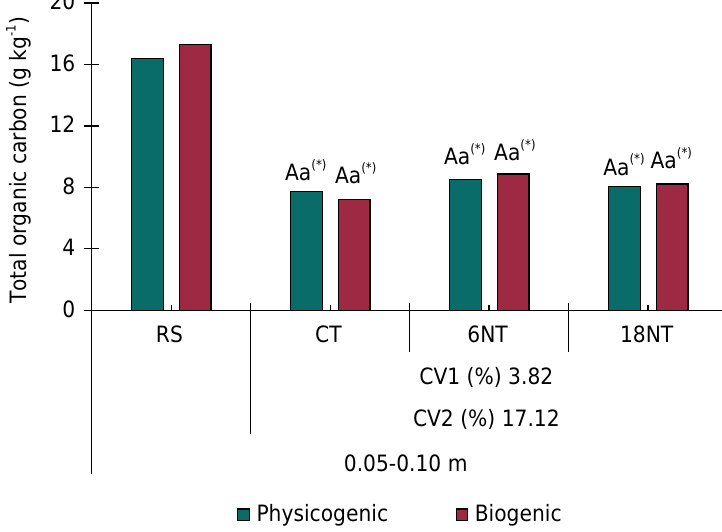
Figure 5. Total organic carbon content in physicogenic and biogenic aggregates in the 0.05-0.10 m soil layer under different management systems in the Cerrado region of Uberaba, Minas Gerais, Brazil. Different uppercase and lowercase letters indicate significant differences between sites and aggregate types, respectively, by Tukey’s test (p<0.05). An asterisk (*) indicates a significant difference from the reference site (Dunnett’s test, p<0.05). ns: not significant; RS: reference site, a well-preserved fragment of the Brazilian Cerrado; CT: 20-year conventional tillage; 6NT: 6-year no-till; 18NT: 18-year no-till; CV 1 : coefficient of variation between aggregate types; CV 2 : coefficient of variation between